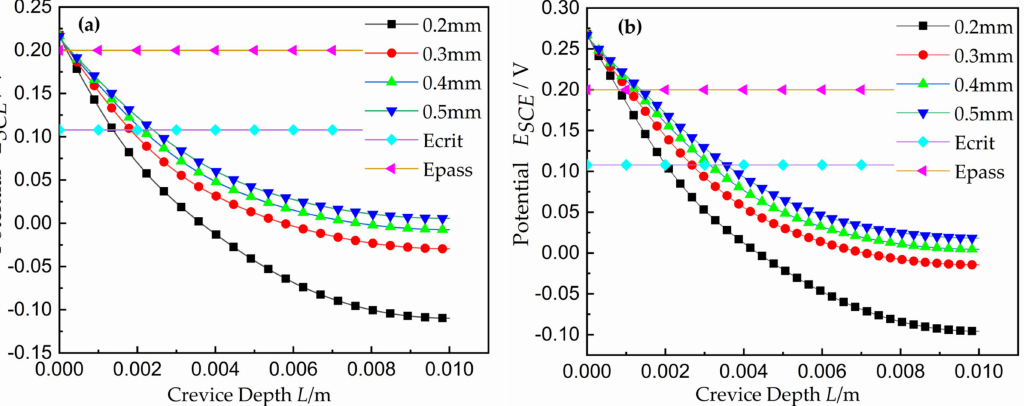
Figure 4. Potential curves with varying crevice width W , at time t = 0 h: ( a ) the applied potential E A = 0.25 V; ( b ) the applied potential E A = 0.30 V.